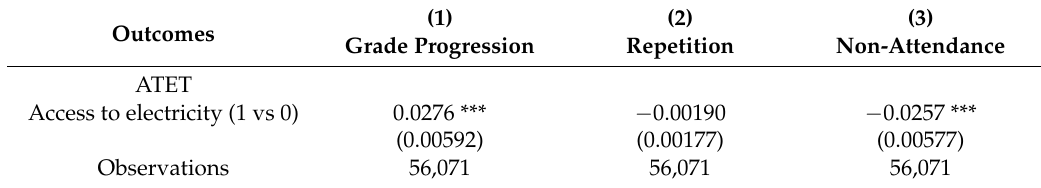
Table 3. Average treatment effect on the treated